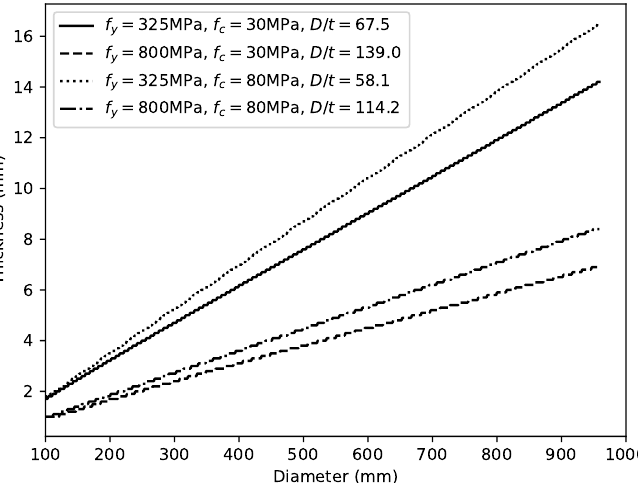
Figure 18. Optimal geometric parameter matches corresponding to different material